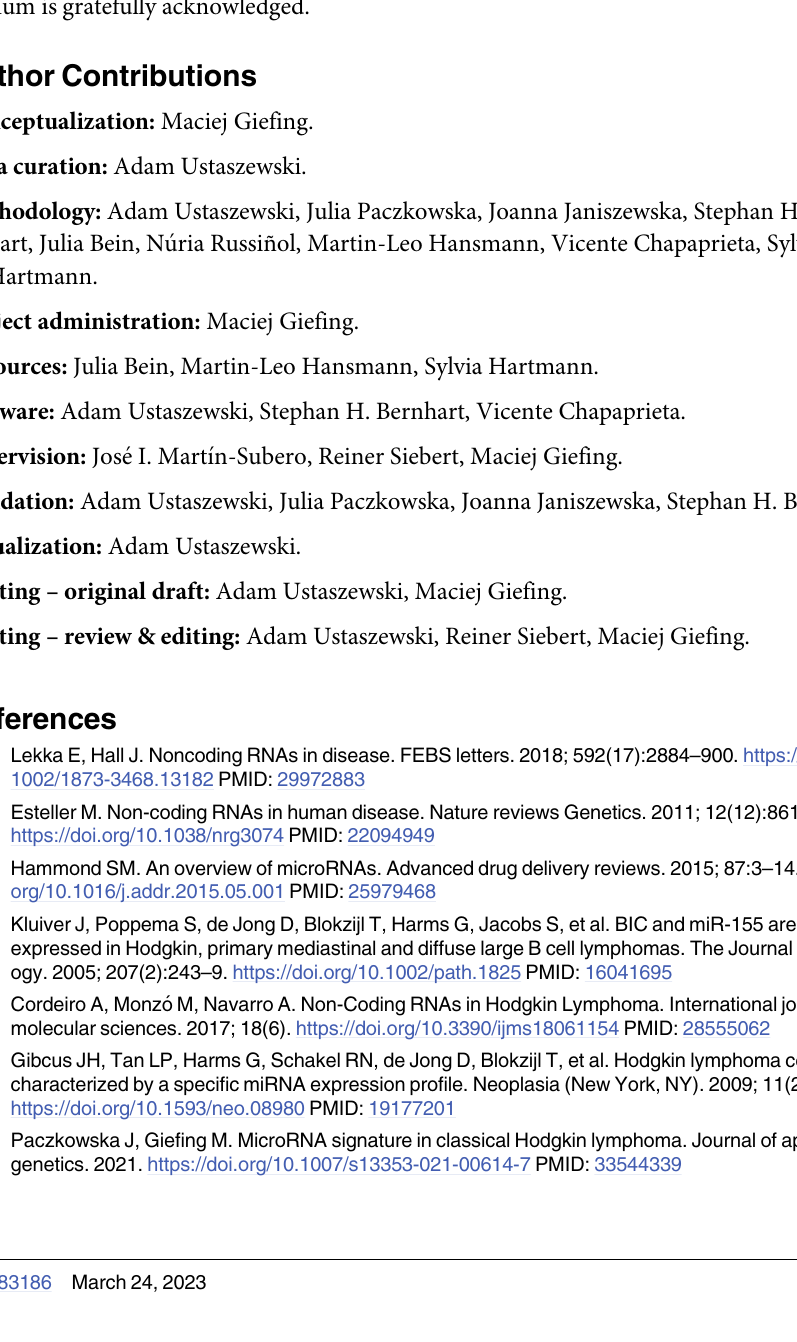
S7 Table. Functional enrichment analysis results. Functional enrichments found in the group of 45 genes that are the putative targets of the novel 2_nv_chr2_212678788 miRNA expressed in cHL cell lines (STRING, GO